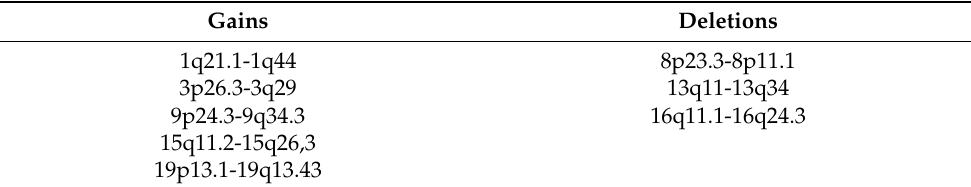
Table 2. Cytogenetic Drivers in MM.